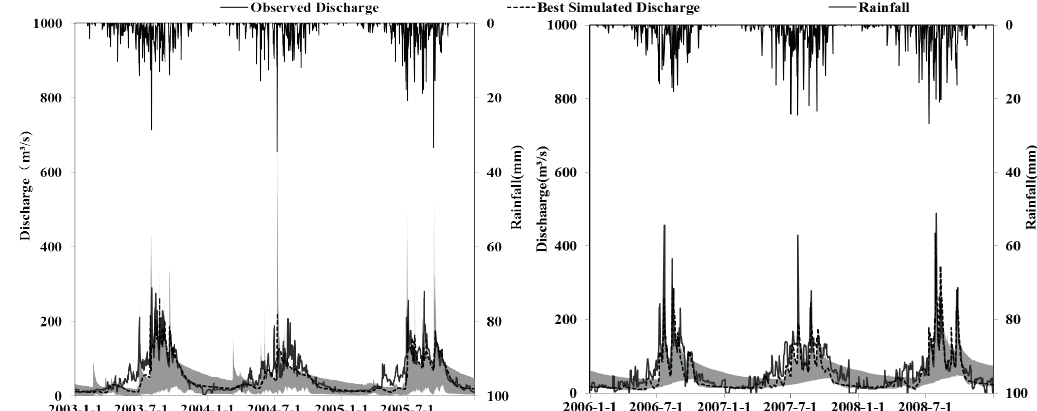
Fig. 2 Rainfall, observed and simulated discharge and 95PPU (shaded area) for calibration using river discharge data of year 2003–2005 and validation period (2006–2008).